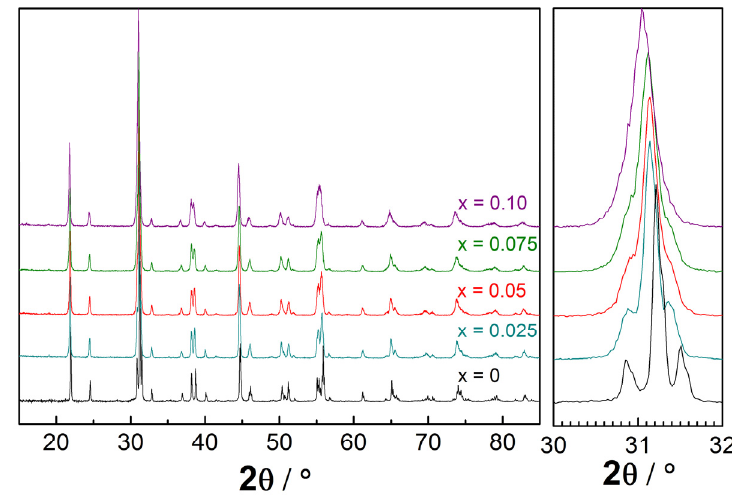
Figure 1. XRD patterns of La 1-x Ba x ScO 3- δ samples.